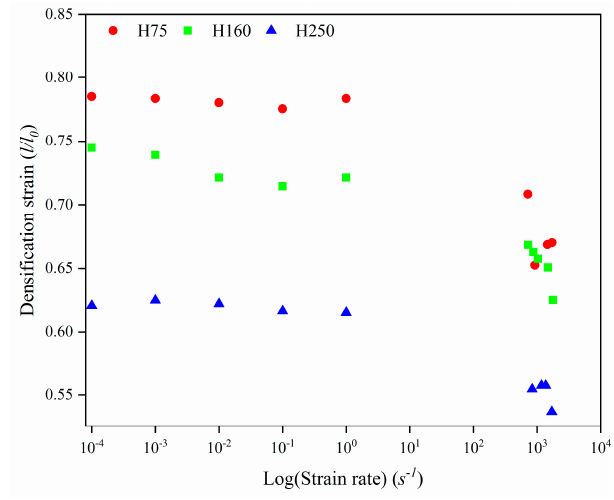
Figure 10. The densification strain over the strain rate (log scale) of PVC foams.